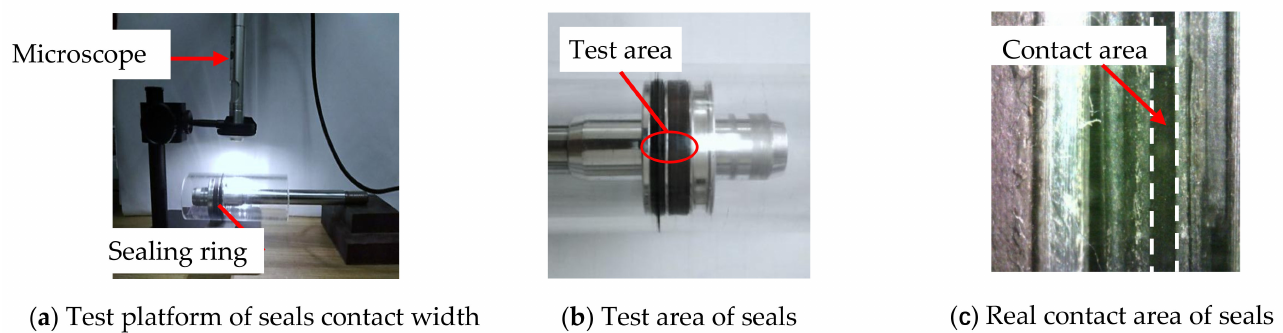
Figure 2. Measurement of contact width between seals and